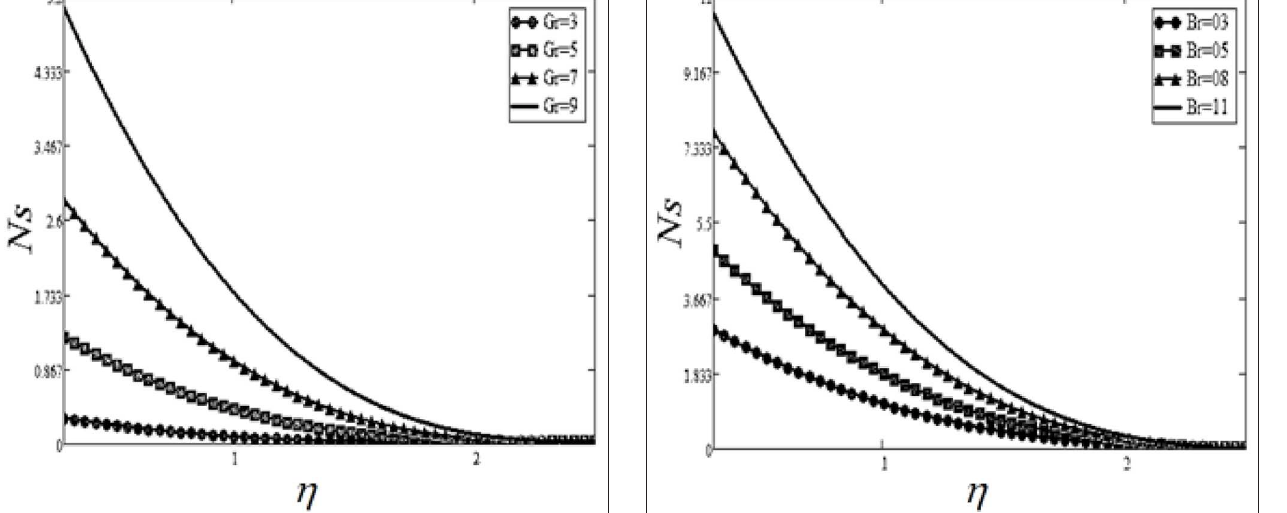
FIGURE 7 | Entropy generation plot for Gr .